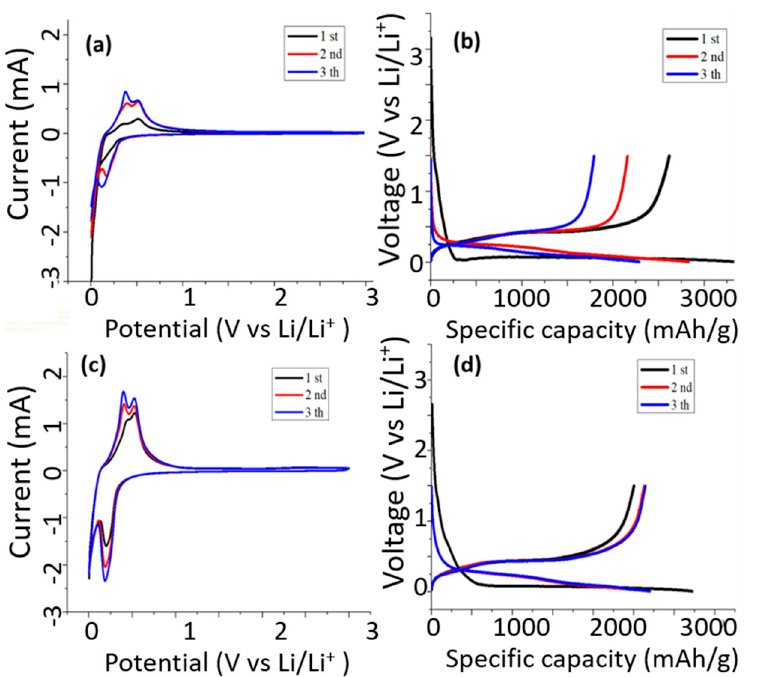
Figure 11. Cyclic voltammetry measurements of anodes made of ( a , b ) pristine silicon flakes and ( c , d ) silicon flakes with combined SiC and RF carbon coatings. The scan rate for ( a , c ) is 0.1mV/s. The discharge/charge rate for ( b , d ) is 200